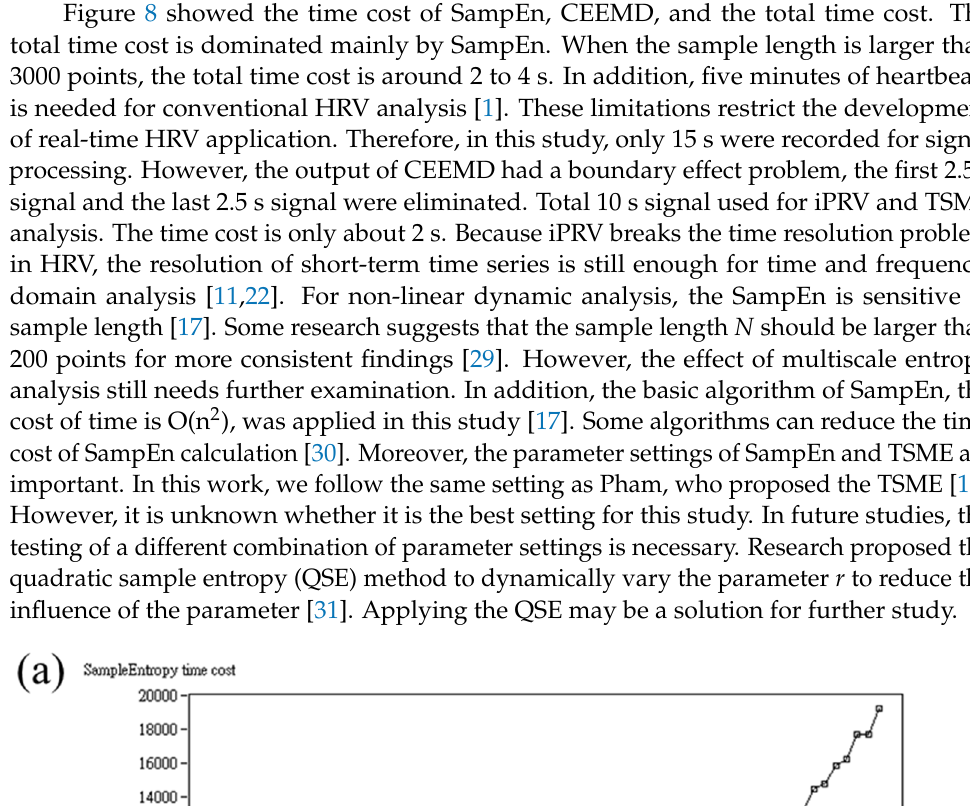
Figure 8. Computing time cost of ( a ) SampEn; ( b ) CEEMD; ( c ) total time cost. 4.3. Fever Detection and Application To measure body temperature, the most common and easy way is using a thermom- eter. However, it is hard to measure body temperature continuously with a thermometer. Another way to measure body temperature is to use a thermographic camera. The ther- mography camera is usually used for measuring the body temperature measurement at the same time. However, the price of a thermographic camera is not cheap. Therefore, in this study, we proposed a new method for detecting fever by using a very short-term PPG signal. Although our method cannot measure body temperature directly, detecting fever is more important. Especially in the ICU, it is necessary to monitor patients who have a